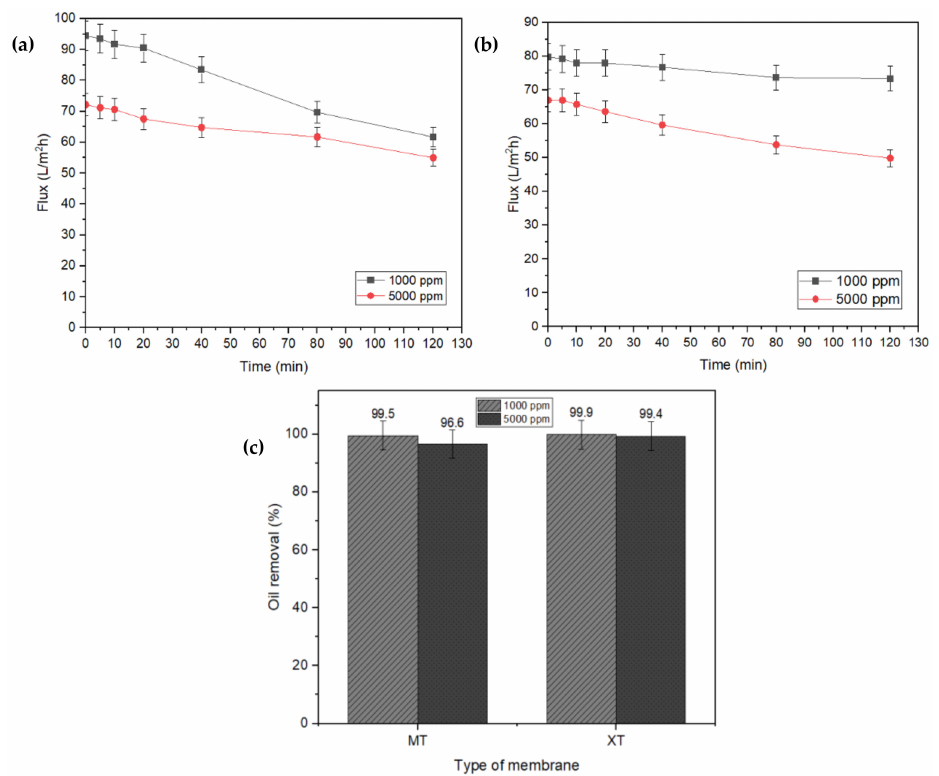
Figure 5. Flux performance of ( a ) MT membrane, ( b ) XT membrane via pressure-filtration method, and ( c ) oil removal percentage upon using MT and XT membrane at 1000 and 5000